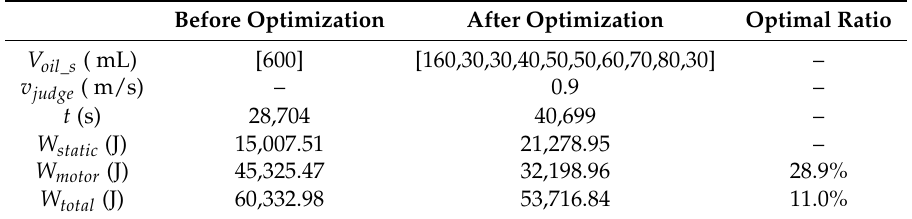
Figure 23. Optimal results of multi-objective optimization model. Panel ( a ) shows the Pareto optimization results and ( b ) shows the variety of the hypervolume value. Table 13. The optimization effect of the NSGA-II method compared with